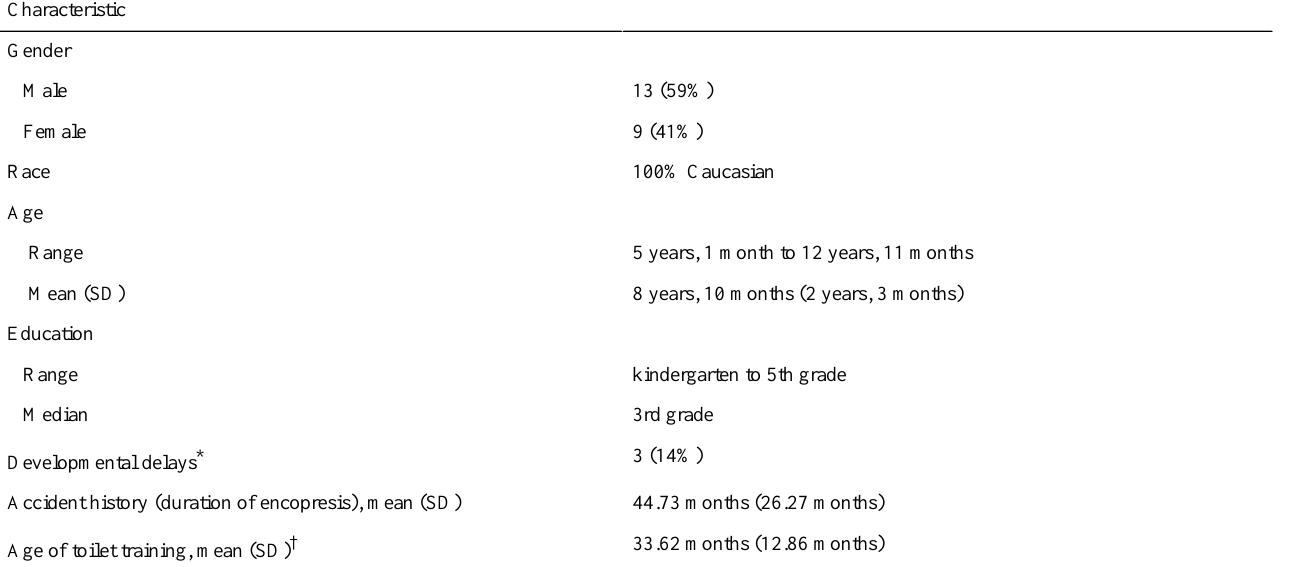
Table 1. Patient characteristics (N = 22)